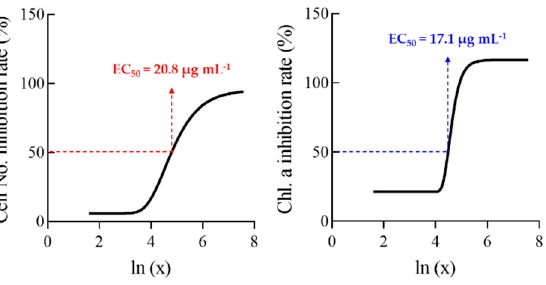
Figure 4. Determination of EC 50 values of tannic acid to inhibit cell number and chlorophyll-a content of Microcystis aeruginosa using dose-response curves.